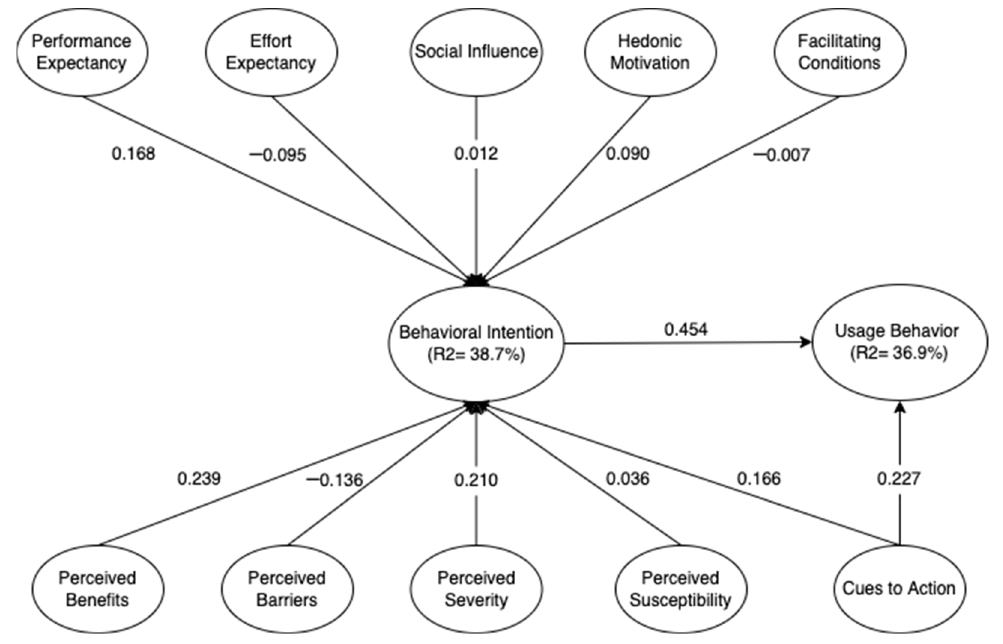
Figure 4. The final SEM for determining the factors affecting the intention to use online grocery apps. Table 9. The model